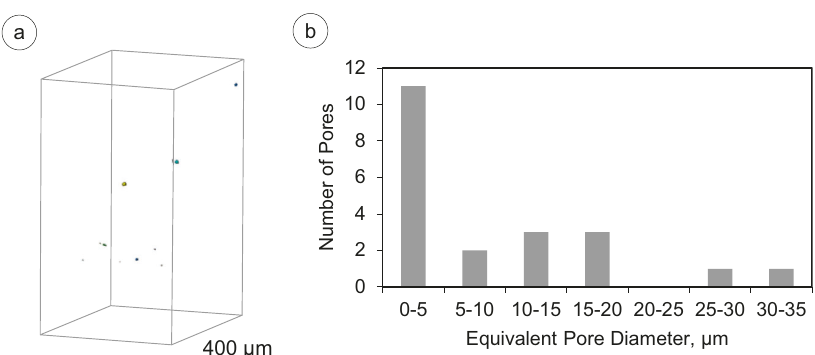
Fig. 3 Analysis of the porosity of the EBM iron. a μ -CT scan of a randomly selected volume in the area of the sample seed of the EBM iron with the detected defect distribution, b histogram of the pore distribution in the probed volume (partly recompiled from ref. 37 ).